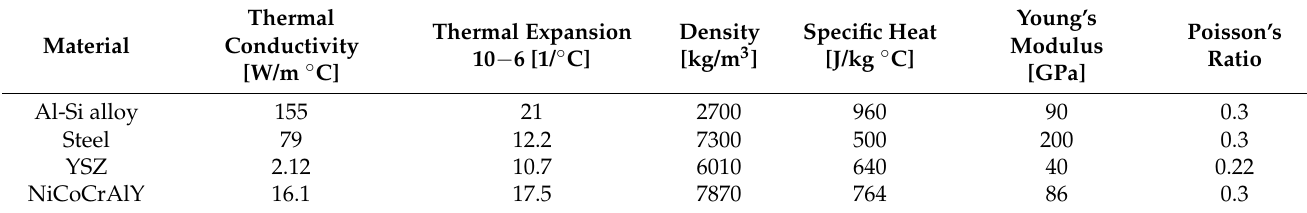
Figure 6. Finite element mesh of thermal barrier coating piston. Table 1. The material properties of YSZ barrier layer, bonding layer and piston substrate.